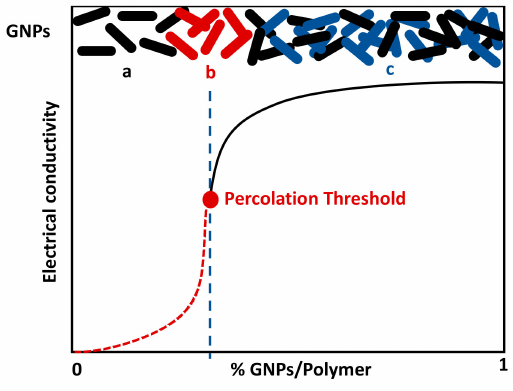
Figure 8. Percolation threshold of composites—adapted from